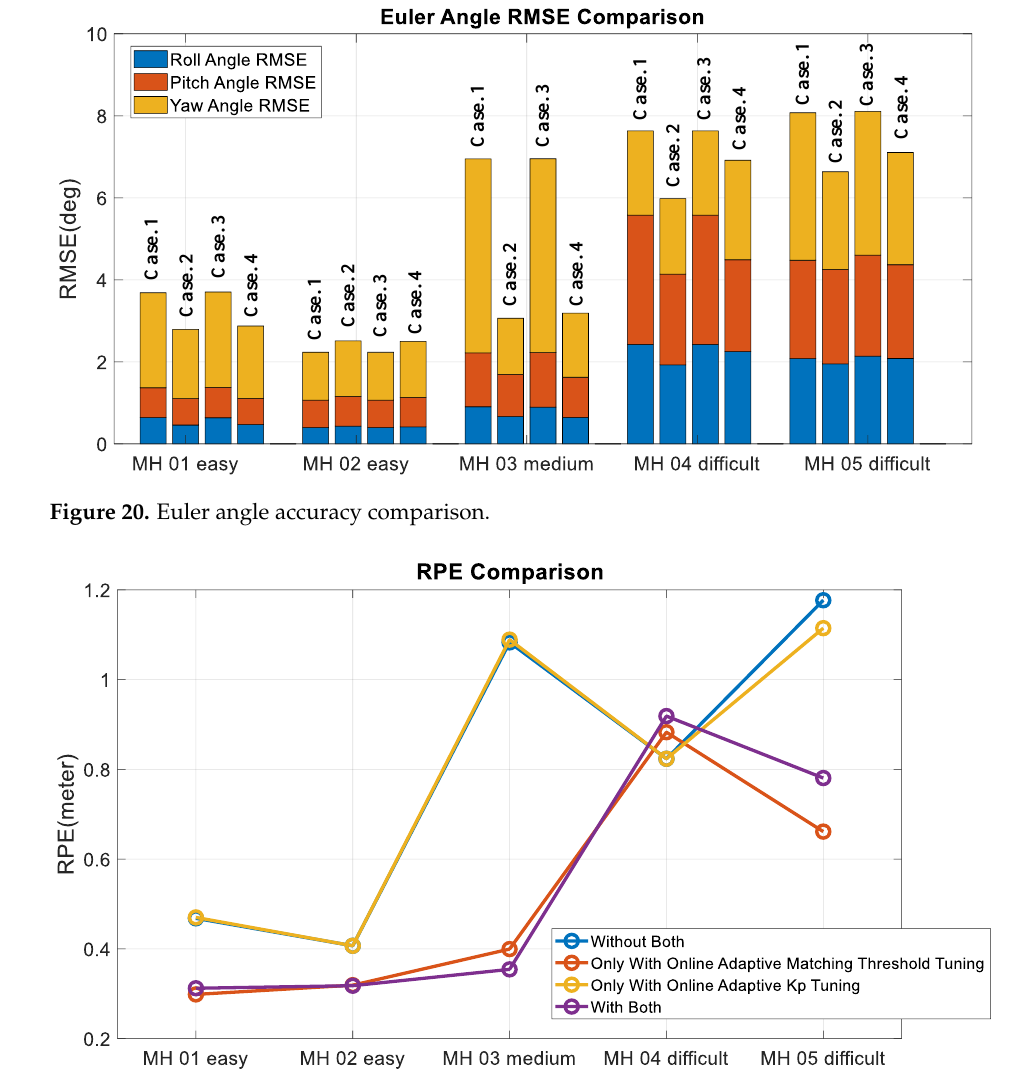
Figure 21. RPE Figure 21. RPE comparison.